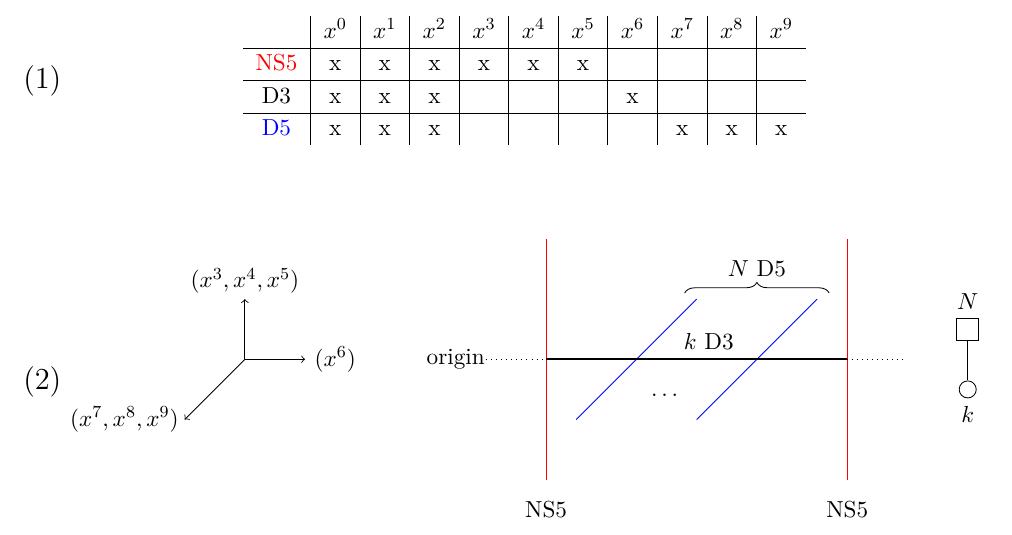
Figure 5 . (1) The Type IIB set-up: the ‘x’ mark the spacetime directions spanned by the various branes. (2) Depiction of the brane system for U( k ) with N